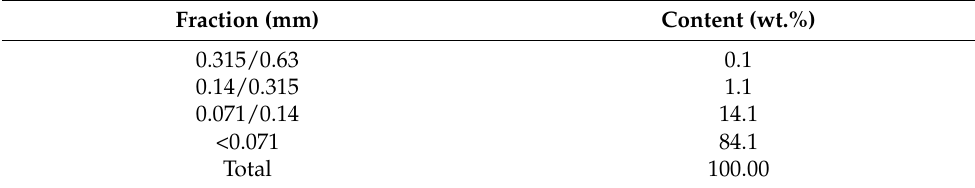
Table 2. Grading of the mineral powder.